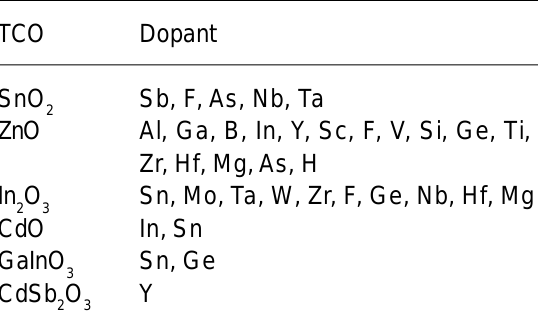
Table 1. TCO Compounds and